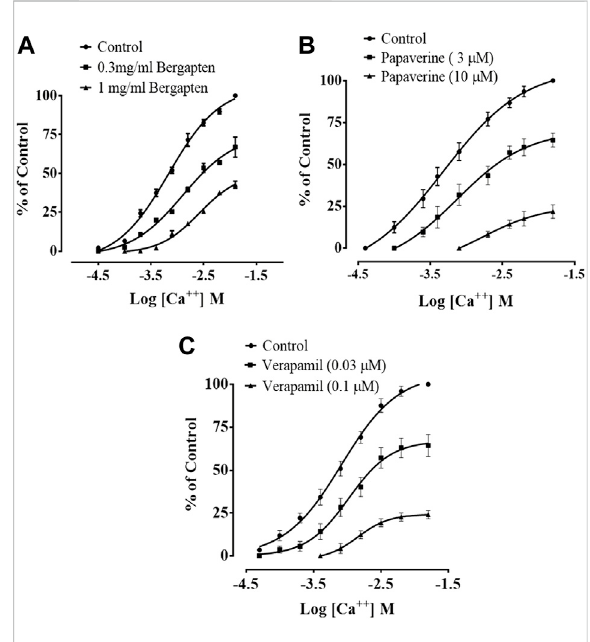
FIGURE 5 Effect of bergapten on concentration – response curves of Ca 2+ in the absence and presence of increasing concentrations of (A) bergapten, (B) papaverine, and (C) verapamil in isolated rabbit jejunum preparations. The values shown are mean ± SEM, n = 3 –